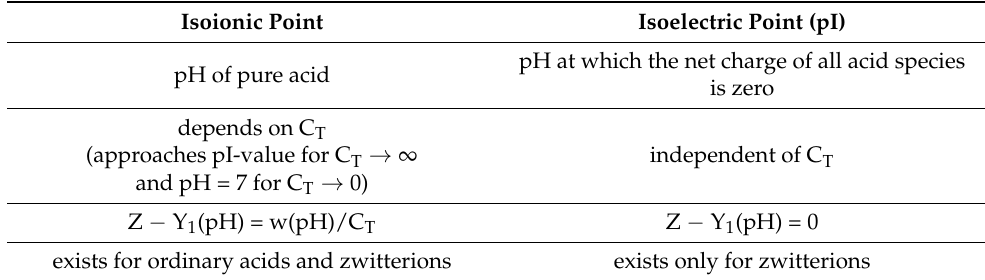
Table 13. Isoionic vs. isoelectric point.